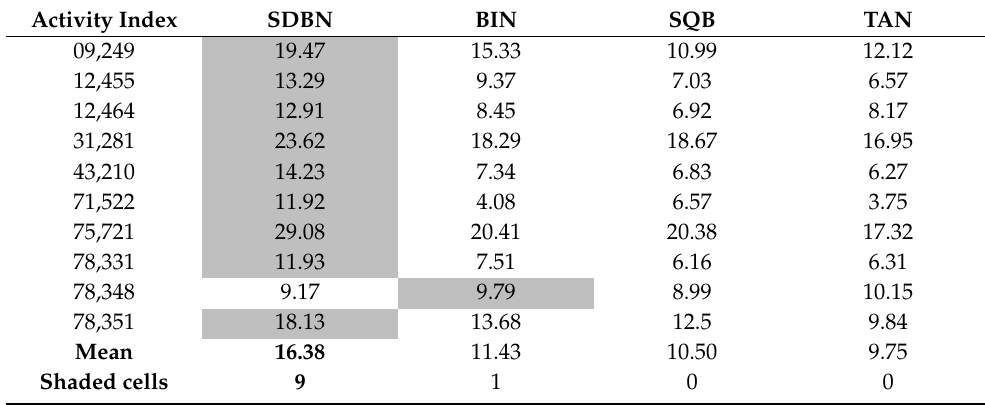
Table 8. Retrieval results of top 1% for MDDR-DS3